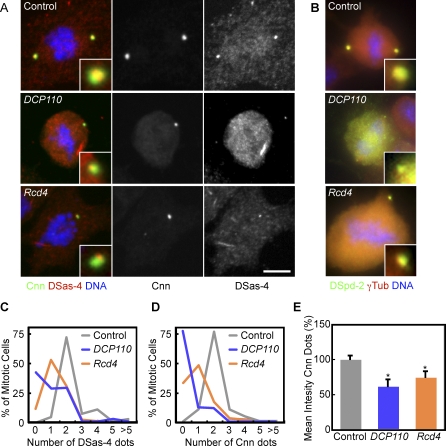
Genes Involved in Both Centriole Duplication and PCM Recruitment (Class II)(A) S2R+ cells treated with dsRNA against GFP (control), DCP110, and Rcd4 (CG17295) were stained with Hoechst (DNA, blue), DSas-4 (a centriole marker, red), and Cnn (a PCM marker, green). Inset shows a 4× magnified view.(B) Recruitment of DSpd-2 (green) and γ-tubulin (red) after dsRNA treatment for control, DCP110, and Rcd4. DNA is shown in blue, and inset shows a 4× magnified view.(C and D) Analysis of centriole (C) and centrosome (D) numbers in mitotic cells after RNAi treatment. More than 30 mitotic cells were counted in three independent experiments.(E) Analysis of PCM size in mitotic cells after RNAi treatment. The graph represents the mean intensity of PCM staining (Cnn) from three independent experiments, each analysing more than 20 centrosomes. Error bars represent the SE; an asterisk (*) indicates p ≤ 0.05 compared to control. Note how the number of centrioles and centrosomes per cell is reduced (C and D), and the amount of PCM recruited to the remaining centrioles is also reduced (E) after DCP110 and Rcd4 depletion.Scale bar in (A and B) represents 5 μm.